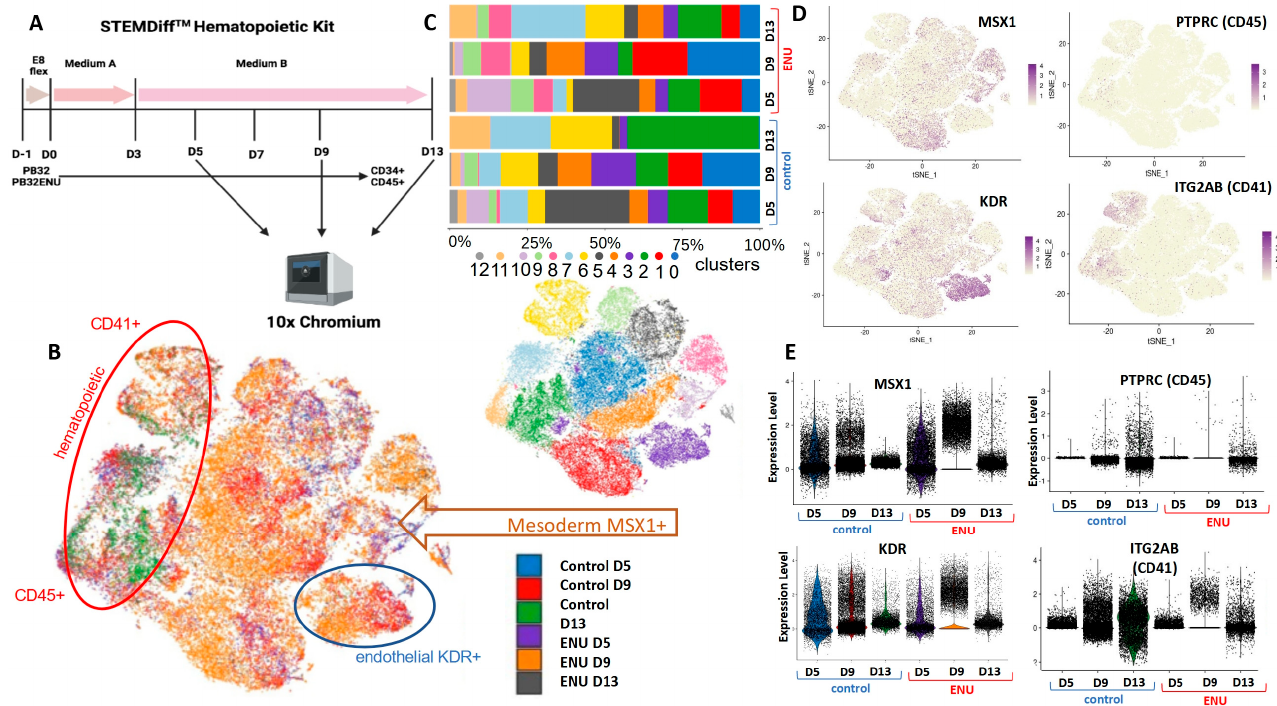
Figure 7. RNA Single-cell transcriptomics analysis of PB32 and PB32-ENU at D5, D9, and D13 of hematopoietic differentiation. ( A ) STEMDiff Hematopoietic differentiation protocol. Cells were analyzed at D5, D9, and D13. ( B ) tSNE analysis stratified on experimental conditions and cell population. ( C ) Bar plot of the percentage of cell population in each experimental condition. ( D ) tSNE analysis of relevant markers of mesoderm (MSX1), endothelium (KDR), and hematopoietic (CD45 and CD41). ( E ) Violin plots show gene expression of MSX1, PTPRC, CD45, and CD41.